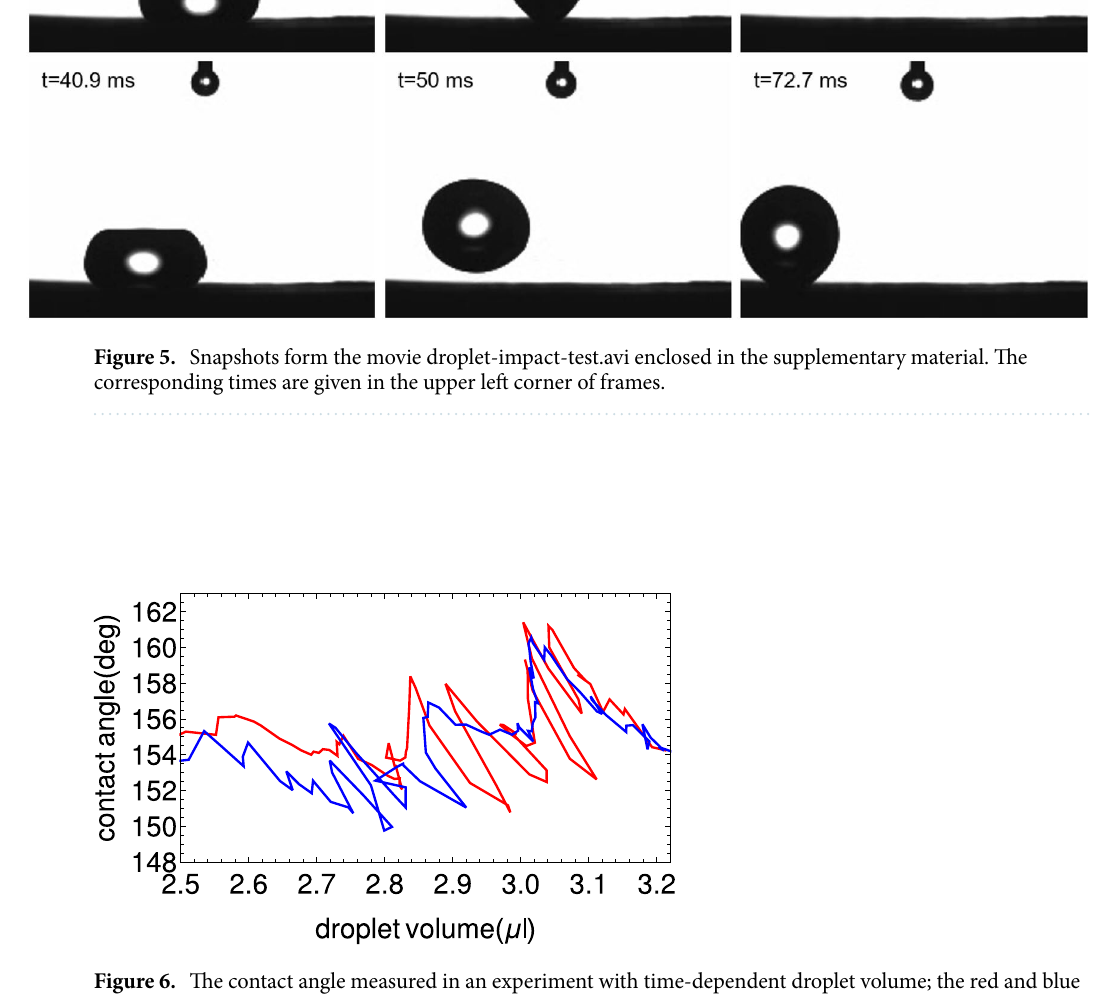
Figure 6. The contact angle measured in an experiment with time-dependent droplet volume; the red and blue curves were obtained for increasing and decreasing volumes at the rate 0.1